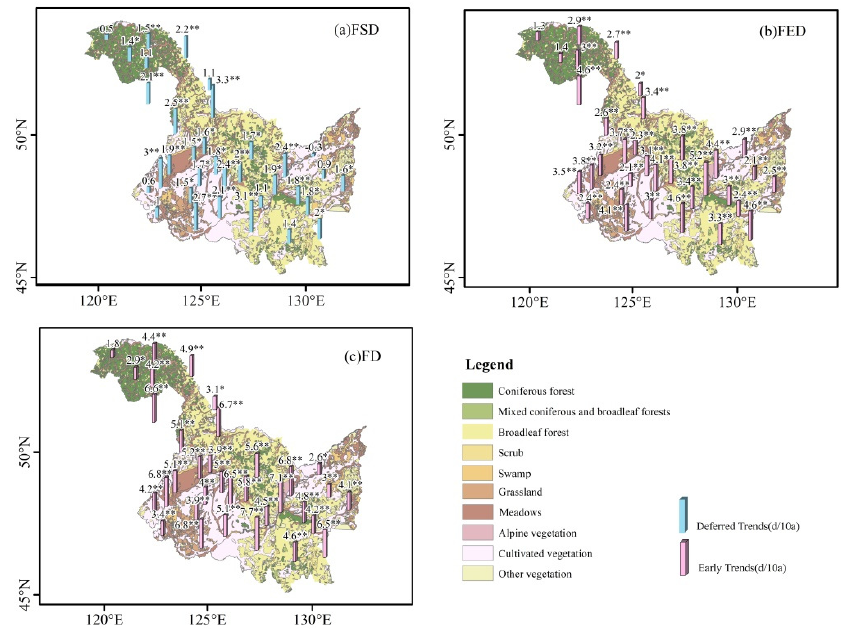
Figure 8. Spatial distribution of key variables of the soil freeze–thaw processes under different vegetation cover types (** indicates reaching a significance level of α = 0.01, * indicates reaching a significance level of α = 0.05).